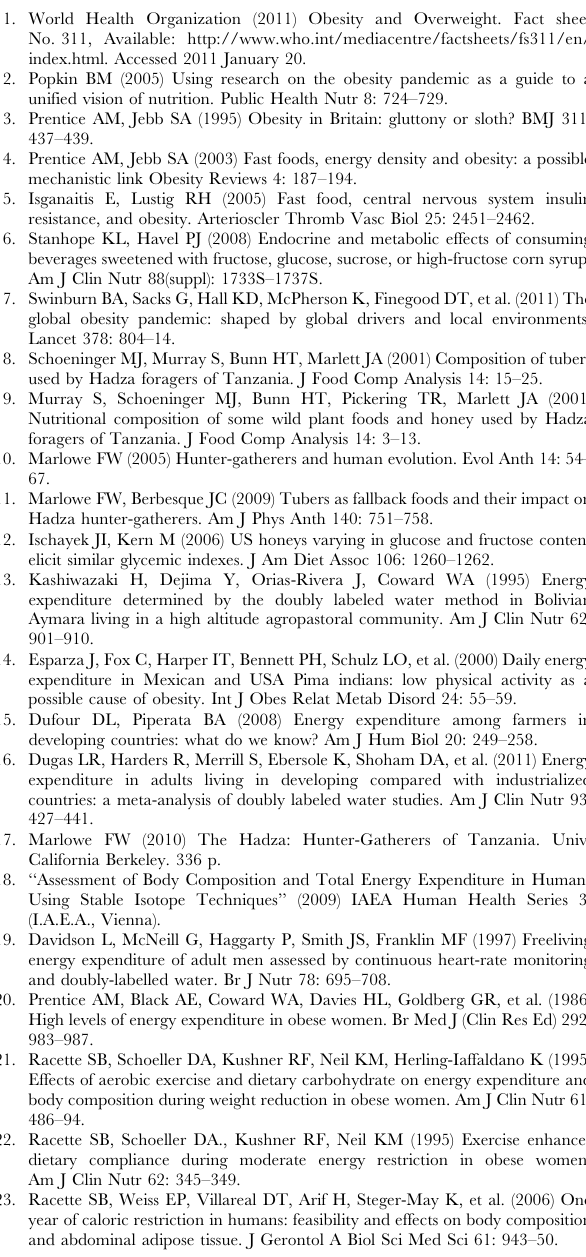
Figure S2 Key foods in the Hadza diet during this study as a percentage of total calories brought back to camp. (TIF) Figure S3 The effect of body size on PAL in the current dataset. A . TEE versus estimated BMR for Hadza and Western adults. Symbols as in Figure 1. B . PAL versus body mass. (TIF) Table S1 Results of multivariate analyses. (PDF) Text S1 Describes additional details of the methods used to collect and analyze data, as well as additional information regarding the Hadza population.